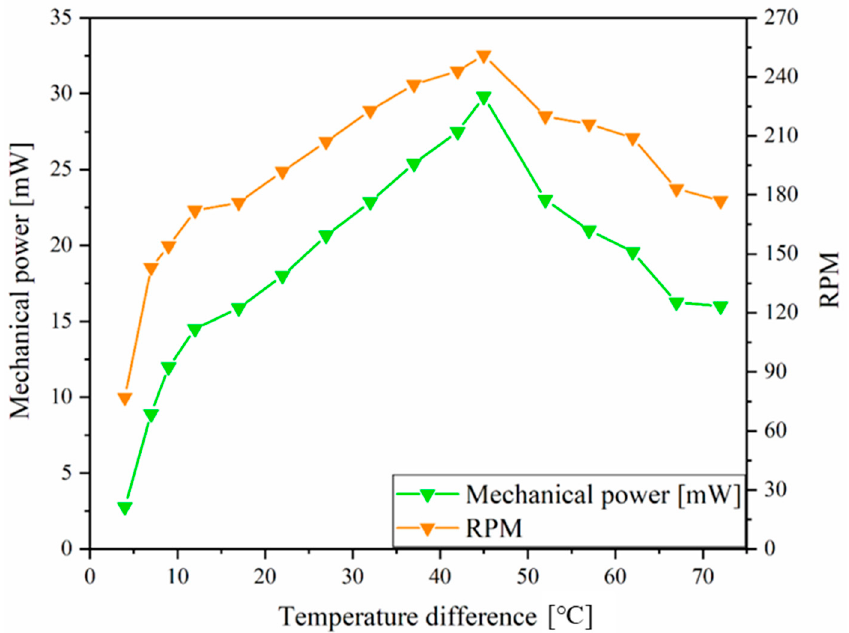
Figure 11. Effect of temperature difference on axial torque and mechanical power of the hybridized EMG/TENG with a horizontal configuration.